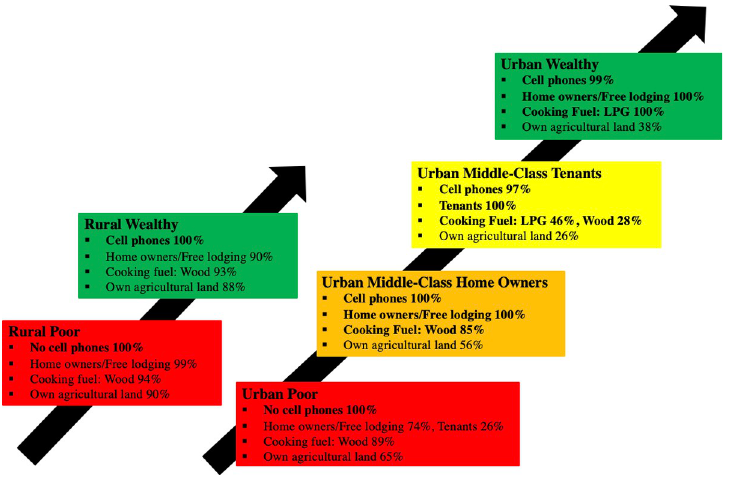
Fig 6. Simplified ordinal economic model for Cameroon.